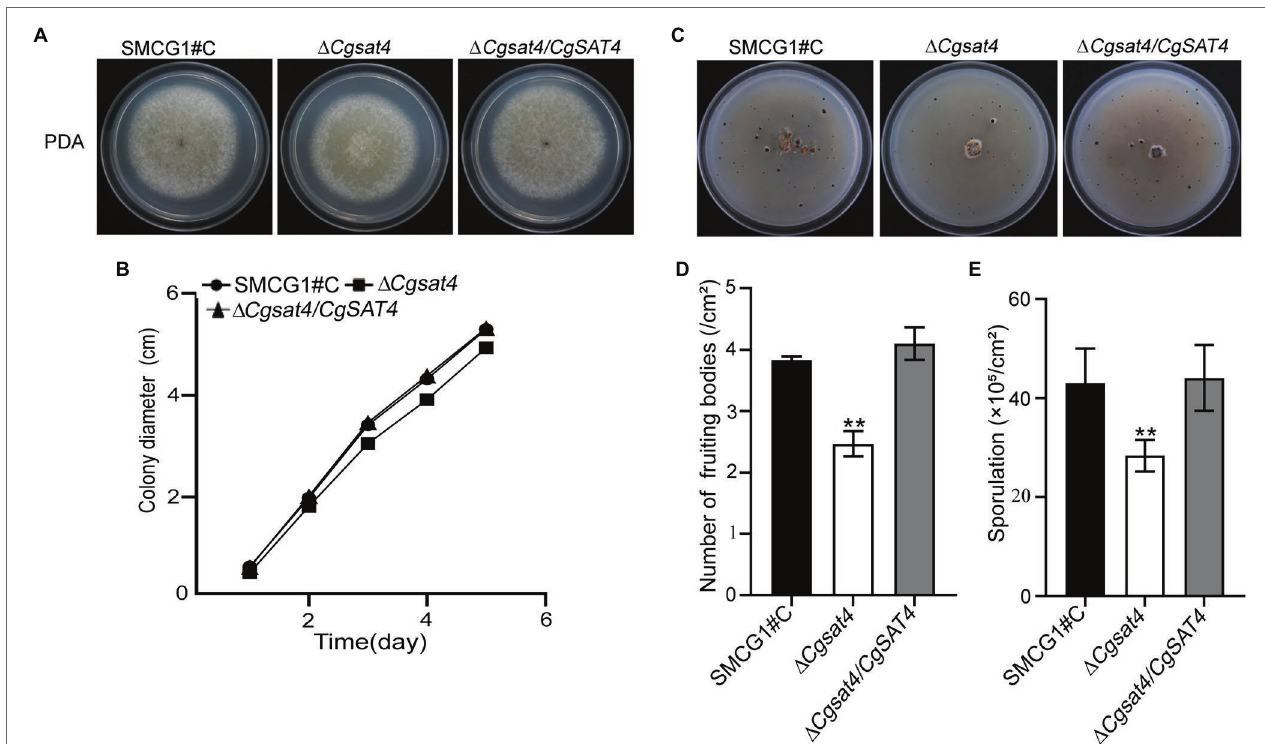
FIGURE 1 | Involvement of CgSat4 in vegetative growth, fruiting body development and sporulation. (A) Colonies of the WT (SMCG1#C), ∆ Cgsat4 mutant and the complemented strain ∆ Cgsat4/CgSAT4 were cultured on potato dextrose agar (PDA) at 25 ° C for 5 days. n = 3. (B) Colony growth kinetics in (A) . n = 3. (C) Fruiting bodies of the WT, ∆ Cgsat4 mutant and the complemented strain formed on the V8 medium for 10 days with 16 h light/8 h dark cycle. n = 3. (D) Quantitative statistics of fruiting bodies in (C) . n = 3. (E) Sporulation of the WT, ∆ Cgsat4 mutant and the complemented strain. n = 3. Error bars represent the SD, and asterisks indicate significant difference at p <